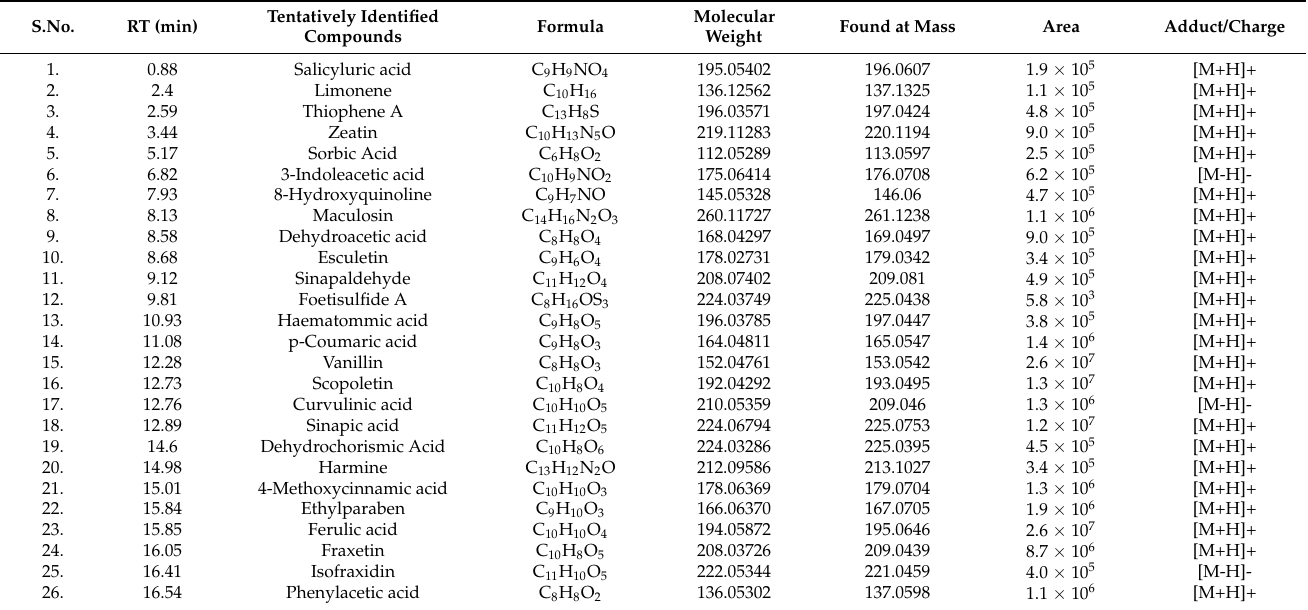
Table 6. Metabolite profiling of the ethyl acetate extract of Penicillium radiatolobatum (EAE-PR) by LC-MS/MS analysis. RT, retention